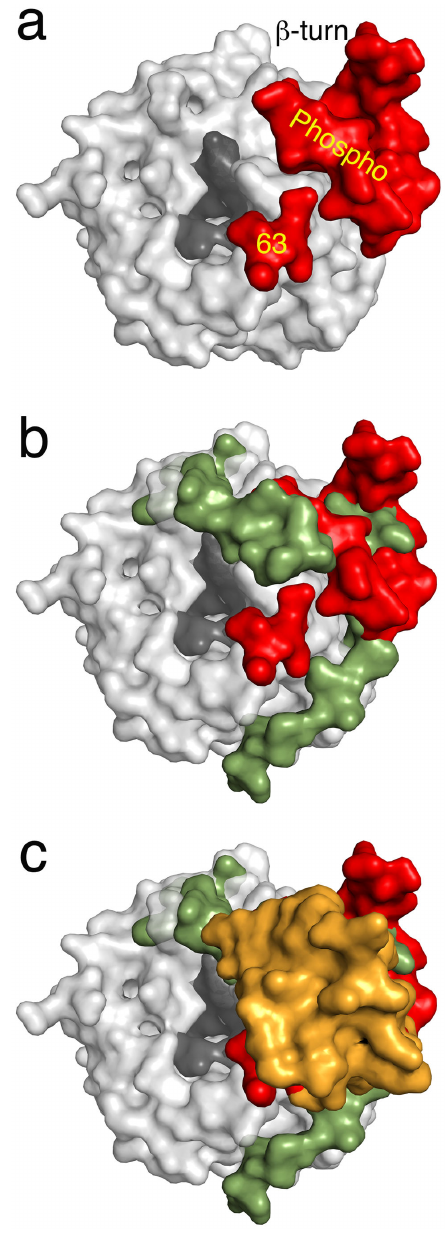
Figure 4. Genetic variations of MetAP’s with additional sequences. Catalytic domains are shown in light grey color while the entrance to the active site in the dark grey. a) Crystal structure of Sp MetAP1a. Two extra inserts are depicted in red. b) Overlay of Sp MetAP1a and Mt MetAP1c. Extension of the N- terminus of the Mt MetAP1c is shown in green. The inserts in the Sp MetAP1a and N-terminal extension in the Mt MetAP1c structurally align well suggesting of common function. c) Overlay of Sp MetAP1a, Mt MetAP1c and Hs MetAP2 structures. The insert domain of the later enzyme is shown in gold color. Note that all three extra modifications on the three different MetAP’s align at the same place reconfirming the common functional roles of these extra